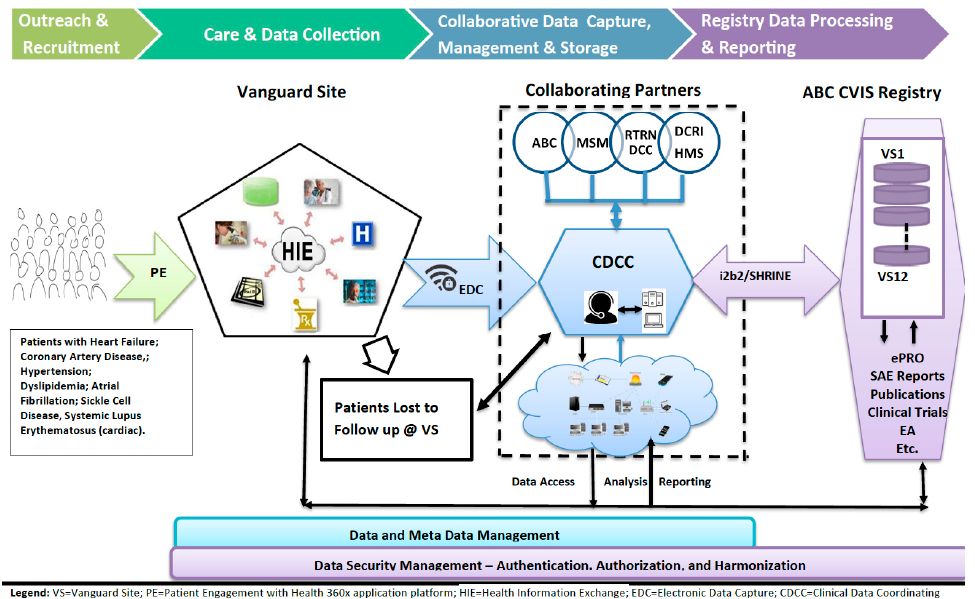
Figure 1. ABC CVIS Registry